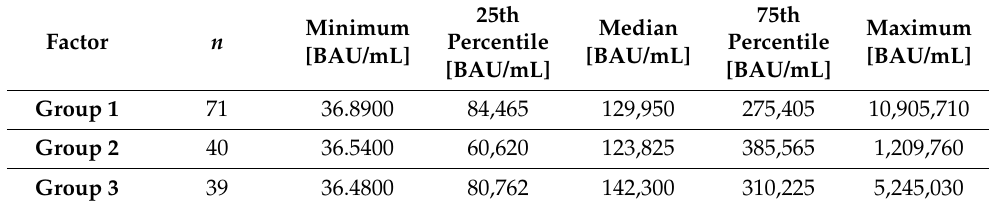
Table 16. The comparison of antibody levels between the three groups in the study.